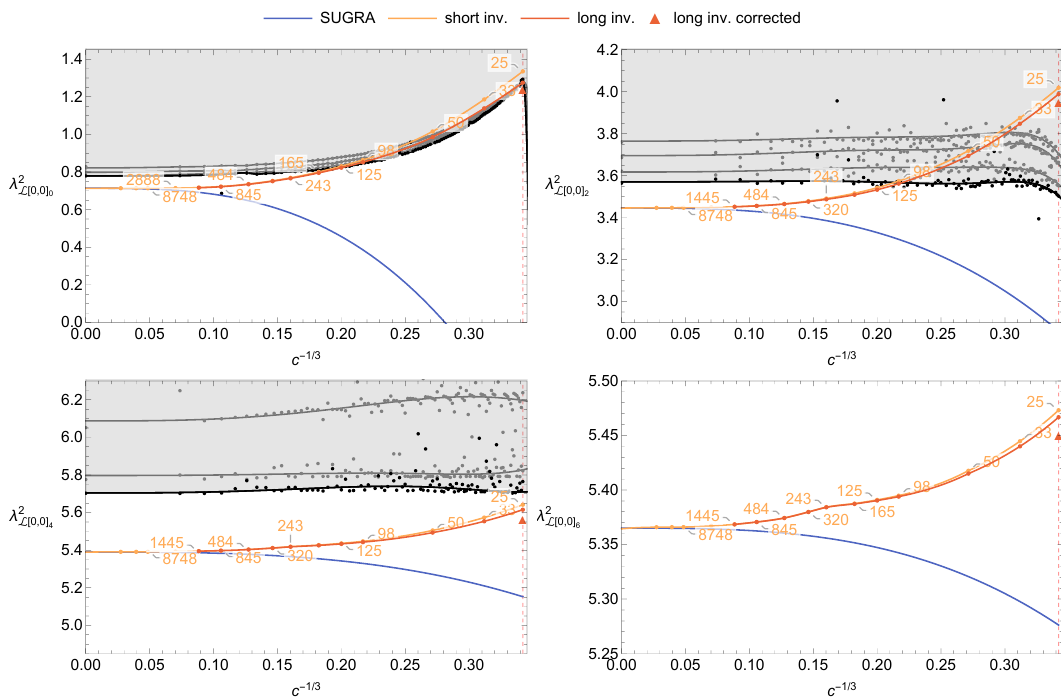
Figure 10. OPE coefficients of leading long multiplets with spin 0, 2, 4, 6, against c − 1 / 3 . The gray shaded regions are unpublished numerical upper bounds (available for spin 0, 2, 4) from [19]. The orange numbers are central charges (a strict subset of the chosen values correspond to physical theories). The orange curves correspond to short inversions and the red curves correspond to stabilized iterative long inversions up to spin 16 (see text for detailed explanation). For c = 25 , we also perform a corrected (triangular point) iterative long inversion using the numerical results of